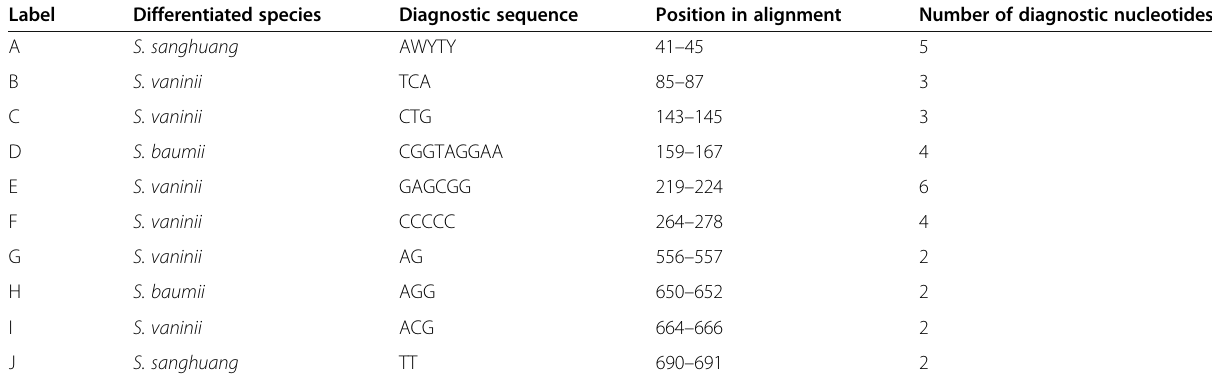
Table 2 Diagnostic sequences with potential for discriminating Sanghuangporus baumii , S. sanghuang , and S. vaninii using Hyperbranched Rolling Circle Amplification. Label and position in alignment are as in Additional file 5: Fig.